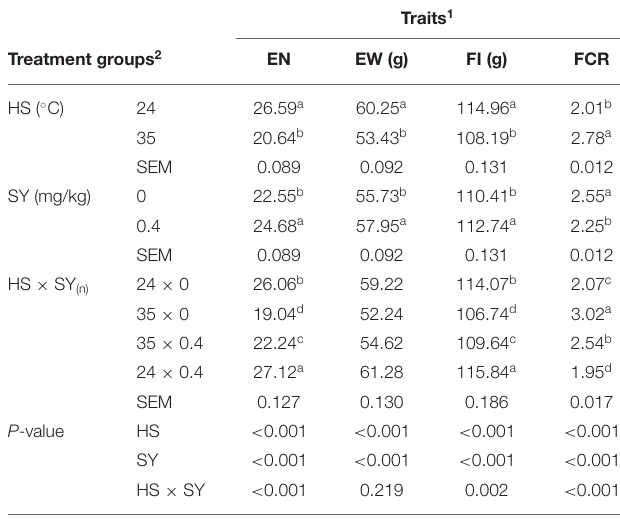
TABLE 1 | Ingredient composition and chemical analysis of the basal diet. Ingredients